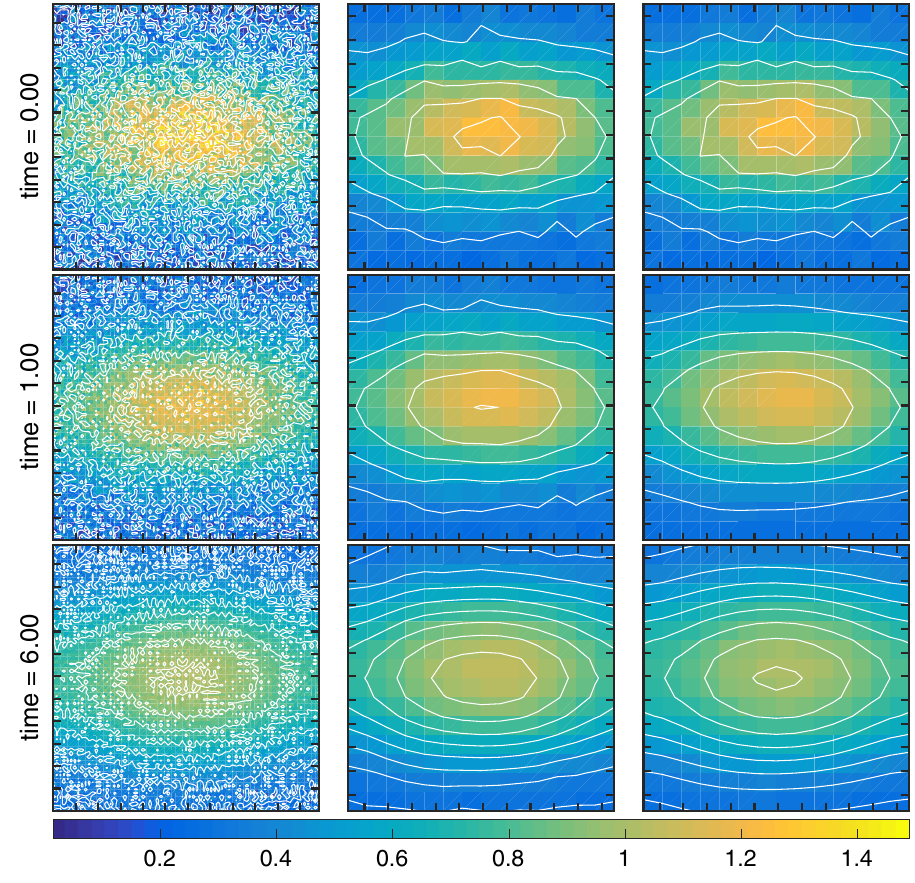
Fig. 1 Simulations of the fluid height h over a square domain of width 2 𝜋 with periodic boundary conditions for: (left column) original pde (1) on a 75 × 75 grid; (middle column) order two slow pde (2) on a 15 × 15 grid; and (right column) order four slow pde (5) on a 15 × 15 grid. Plots in the same row are simulated at the same time, and all plots are coloured according to the same colour bar (shown below the row of plots). At any one time, all three plots have the same contour levels, but plots at different times have differ- ent contour